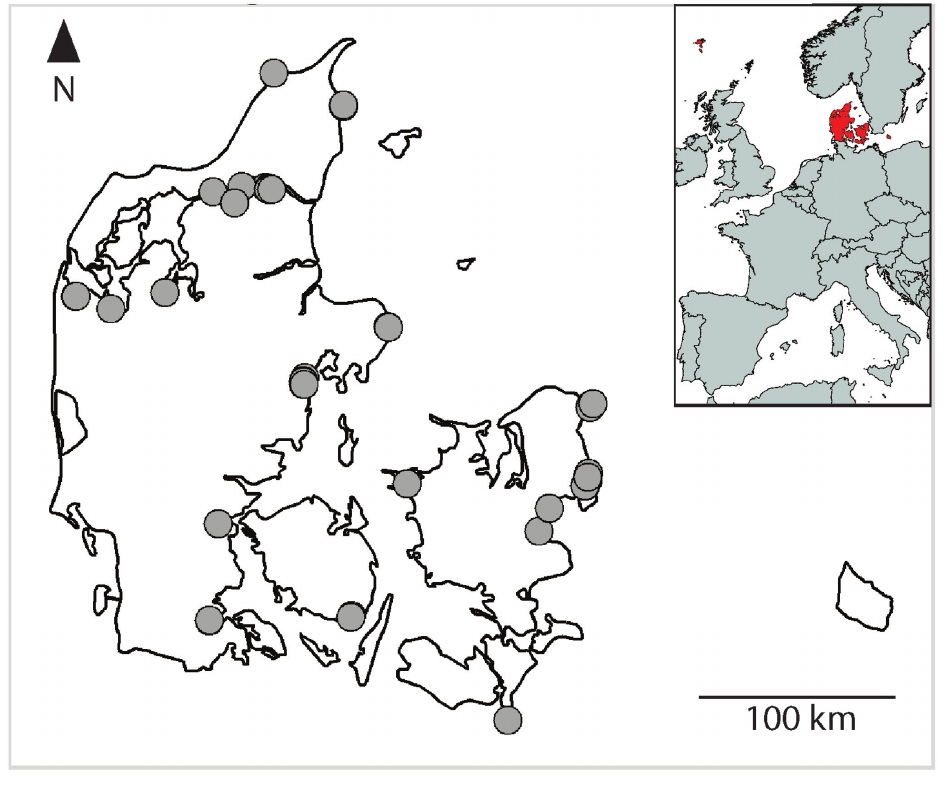
Figure 1 Geographical distribution across Denmark of the 47 analyzed marine samples from 2017–2018. Many samples overlap, explaining the limited number of sampling sites plotted.